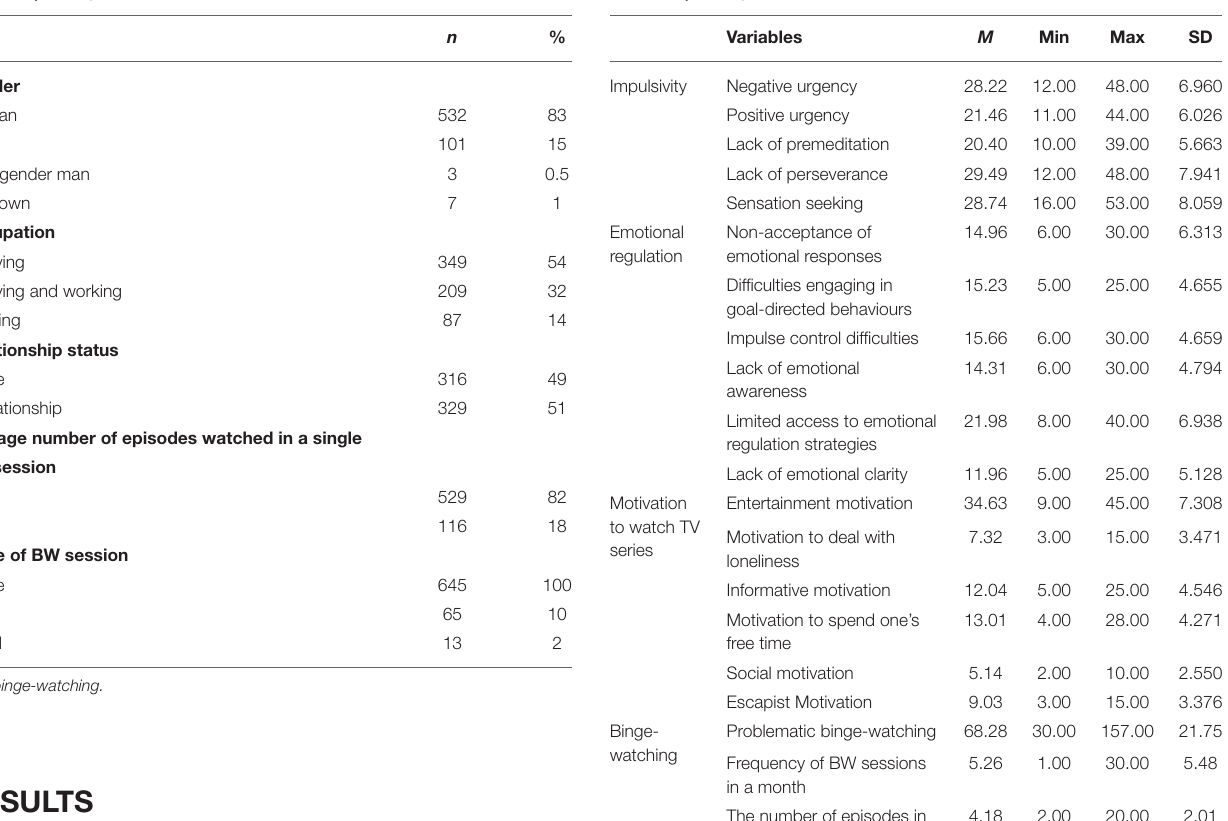
TABLE 1 | Participant characteristics. TABLE 2 | Descriptive statistics of research